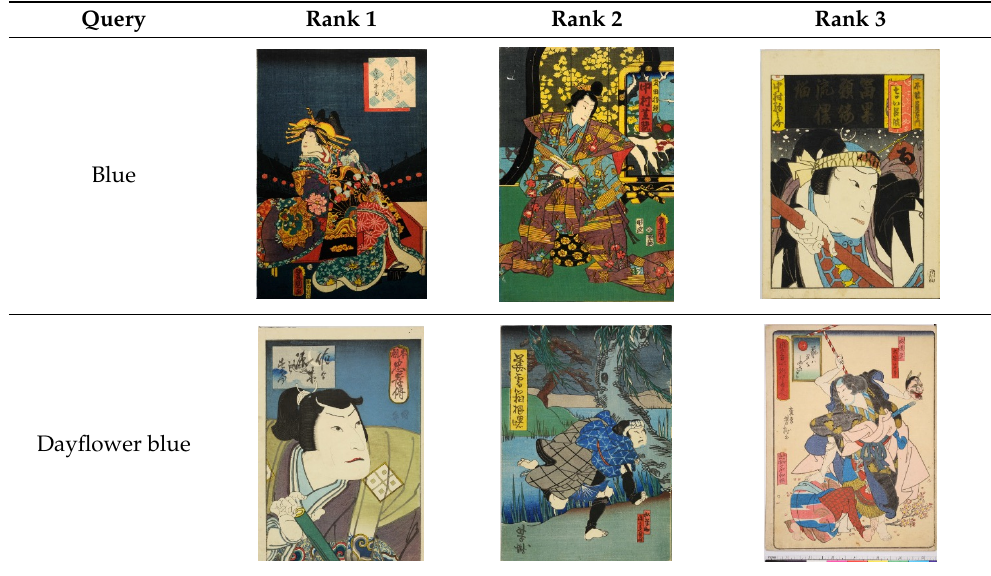
Table 14. Top 3 results for query ‘Blue’ and ‘Dayflower blue’.